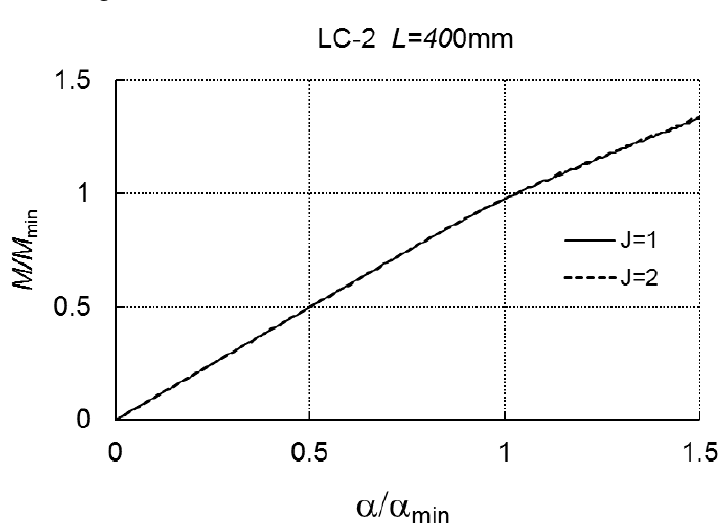
Figure 8. M / M min versus α / α min for LC-2 and L = 250 mm.